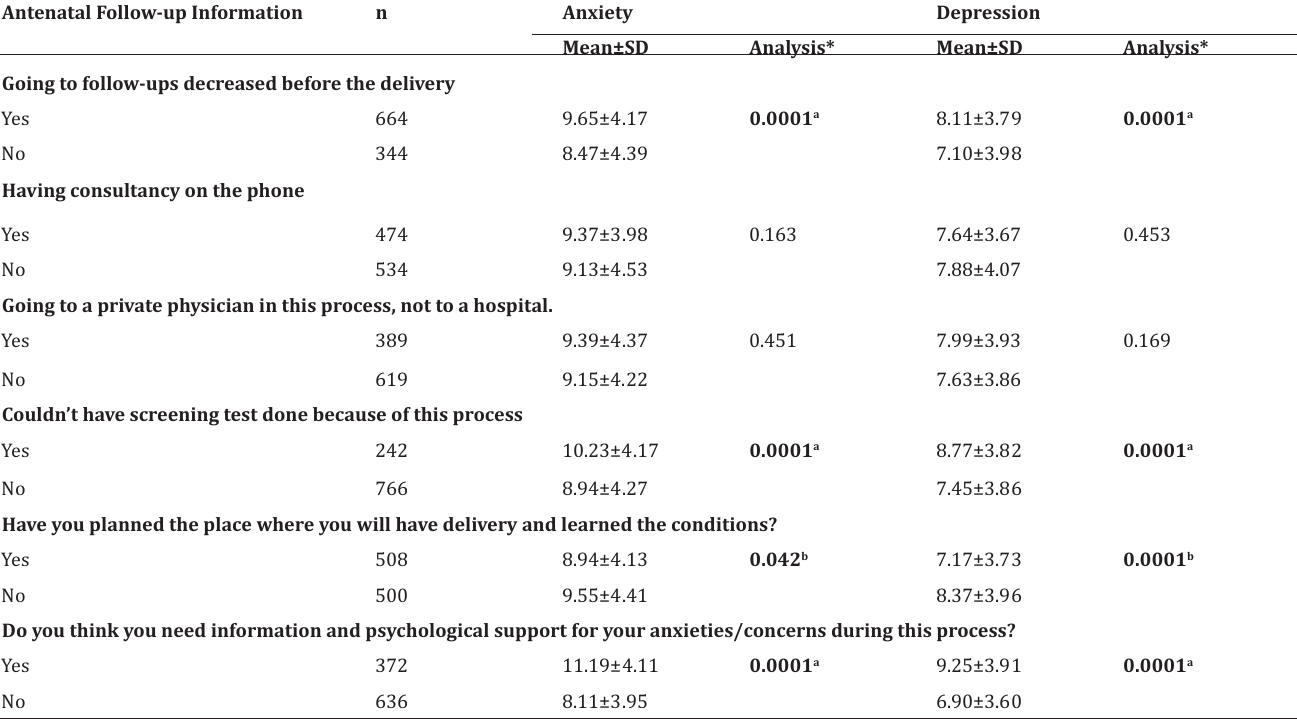
Distribution of anxiety and depression scores of pregnant women according to antenatal follow-up Antenatal Follow-up Information